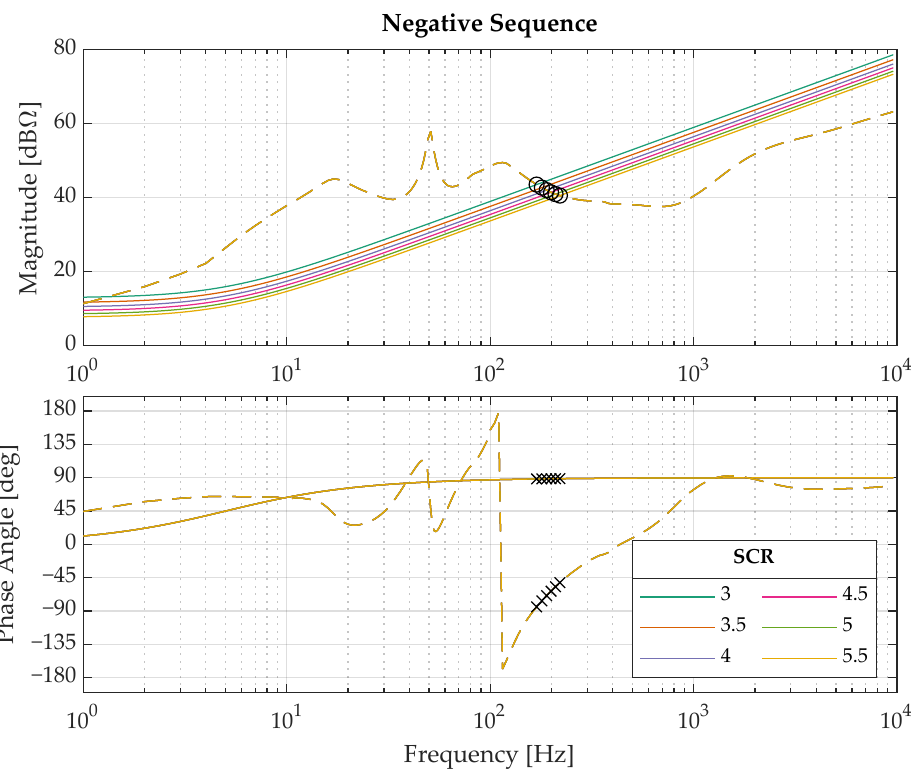
Figure 24. Bode plots of MMCs in grid-following control mode and AC grid for different SCR with negative-sequence perturbation. Table 5. Phase Margins of MMC in grid-following control mode and AC grid for different